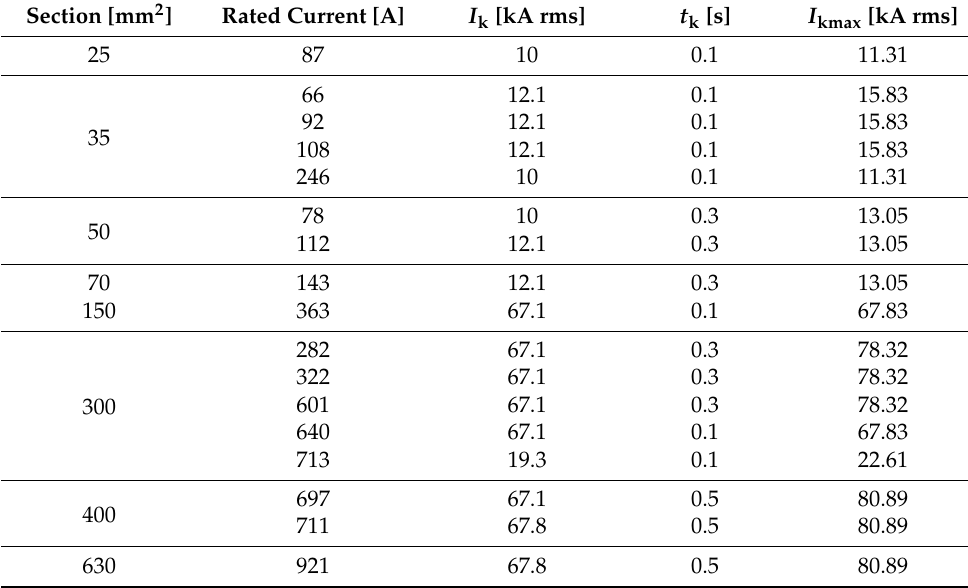
Table 16. Electrical data assumed for 0.4 kV